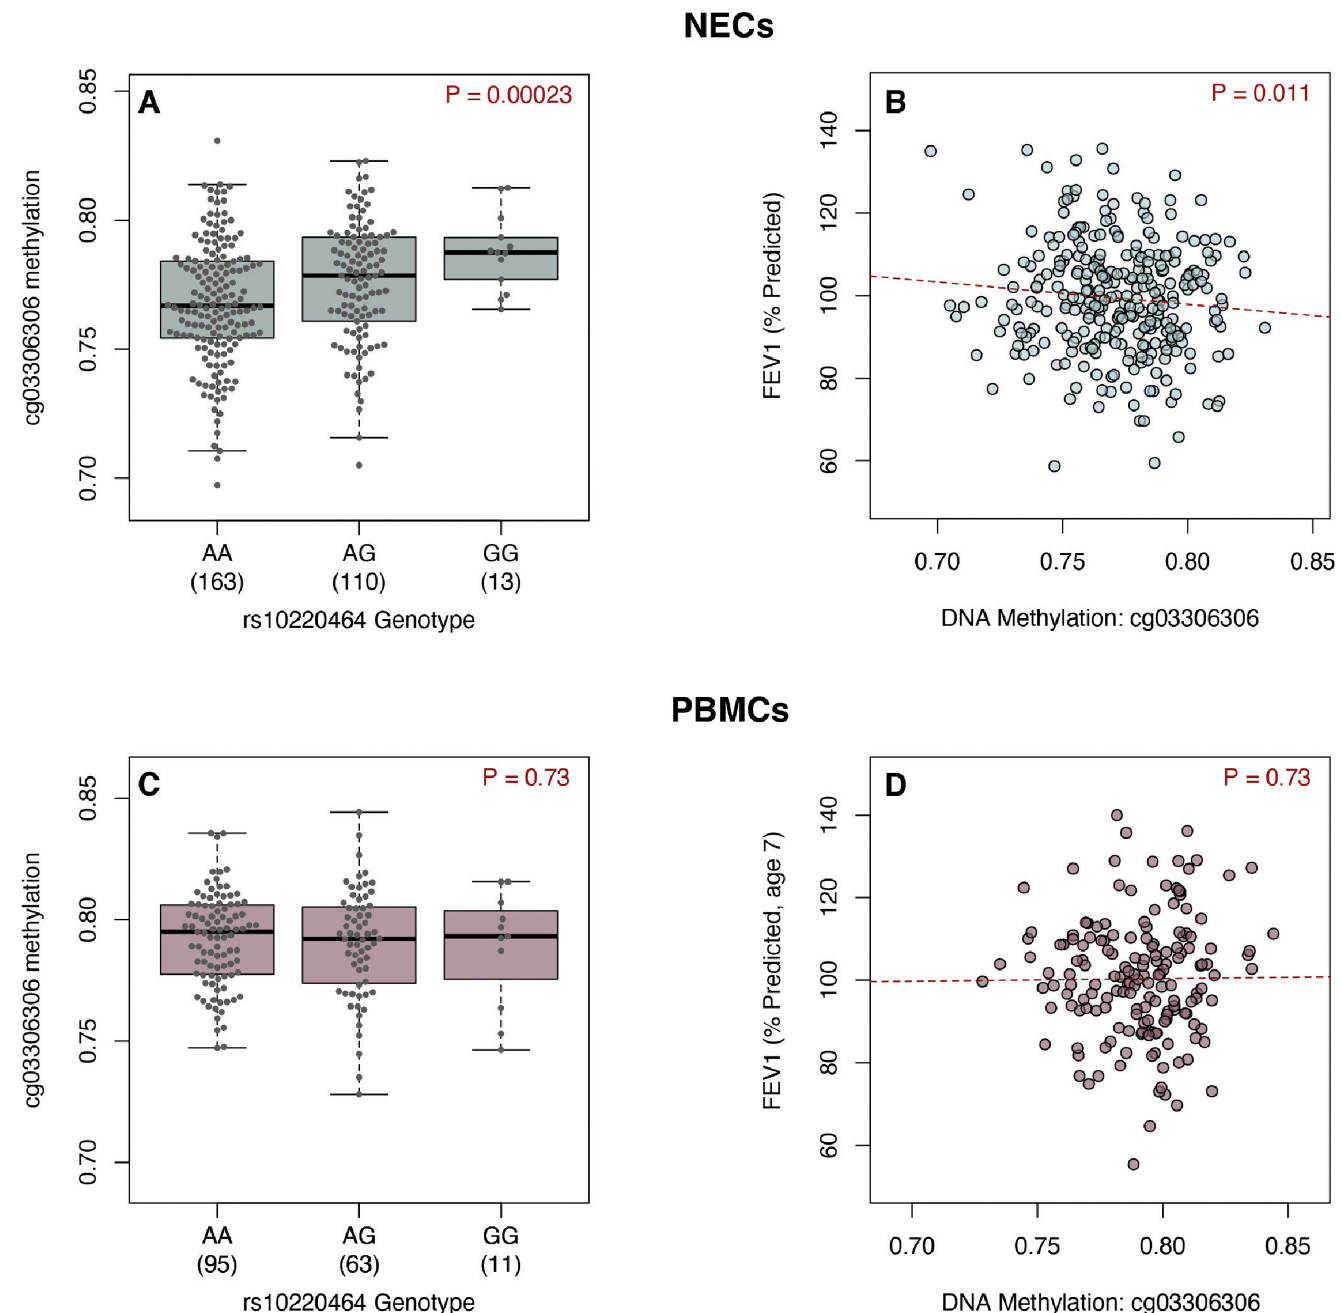
Fig 5. Genotype and FEV 1 associations with DNA methylation. DNA methylation levels at cg03306306 are shown by rs10220464 genotype and FEV 1 measures are plotted against cg03306306 methylation levels in NECs at age 11 (A, B), and PBMCs at age 7 (C, D) from URECA. FEV 1 , forced expiratory volume in one second; NECs, nasal epithelial cells; PBMCs, peripheral blood mononuclear cells; URECA, Urban Environment and Childhood Asthma